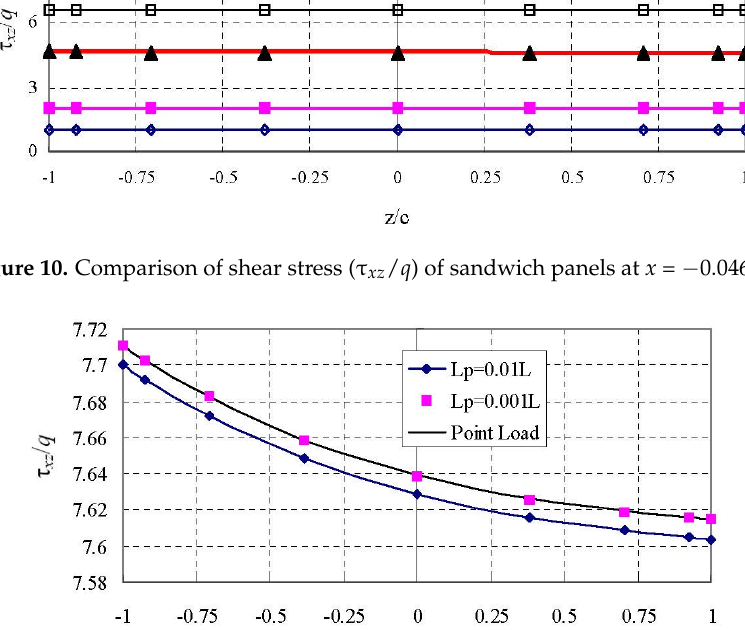
Figure 11. Through-thickness distribution of the shear stress ( τ xz / q ) for sandwich panels under